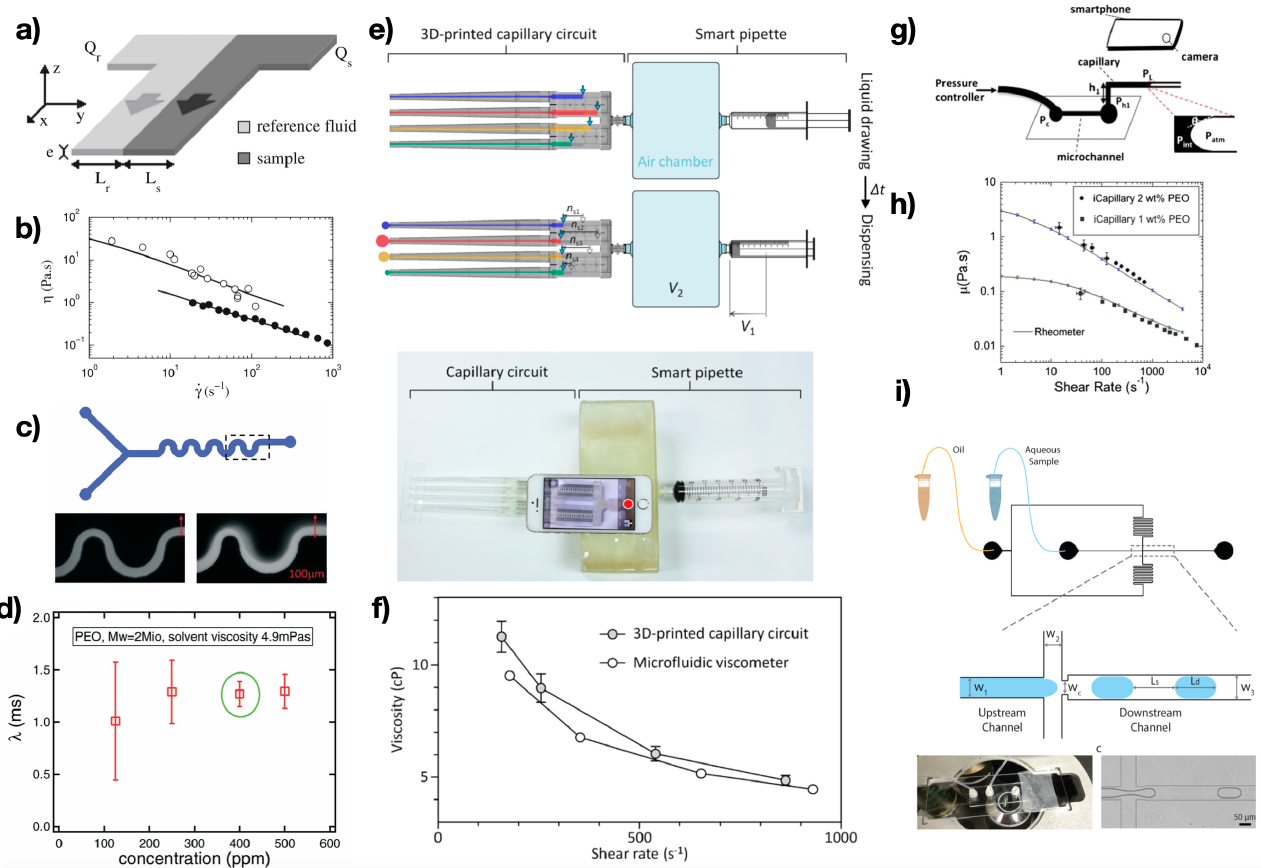
Figure 3. Examples of microfluidic rheometers based on interfacial phenomena. ( a ) The interface between a reference Newtonian liquid and a sample is studied to obtain the viscosity of the sample liquid. ( b ) Measurements carried out using the device in ( a ) on PEO solutions at 2 and 4 wt%. Reprinted with permission from Springer Nature, Microfluidics and Nanofluidics, Guillot and Colin, Copyright (2014) [27]. ( c ) Serpentine microfluidic device for the measurement of longest relaxation time in curved microfluidic devices. ( d ) Measurement of longest relaxation time for several PEO solutions in the dilute regime. Reprinted from Zilz et al. [28]. ( e ) Schematic of the 3D printed capillary circuit microfluidic rheometer. ( f ) Good agreement was found between the 3D printed capillary circuit data and those obtained using another microfluidic rheometer. Reprinted from Oh et al. [29]. ( g ) Schematic of the iCapillary device based on monitoring the sample air interface using a smart- phone. ( h ) Good agreement was found between iCapillary data and conventional rheology data for PEO solutions. Reprinted with permission from Springer Nature, Rheologica Acta, Solomon et al., Copyright (2016) [30]. ( i ) Microfluidic rheometer based on the droplet formation mechanisms in flow- focusing geometry. Reprinted with permission from Li et al., Analytical Chemistry, 89, 3996–4006 [31]. Copyright 2017, American Chemical